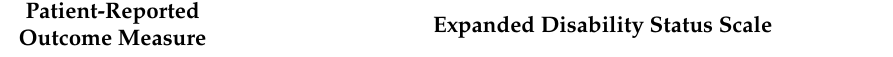
Table 8. Mean values of patient-reported outcome measures for subcategories with a significant